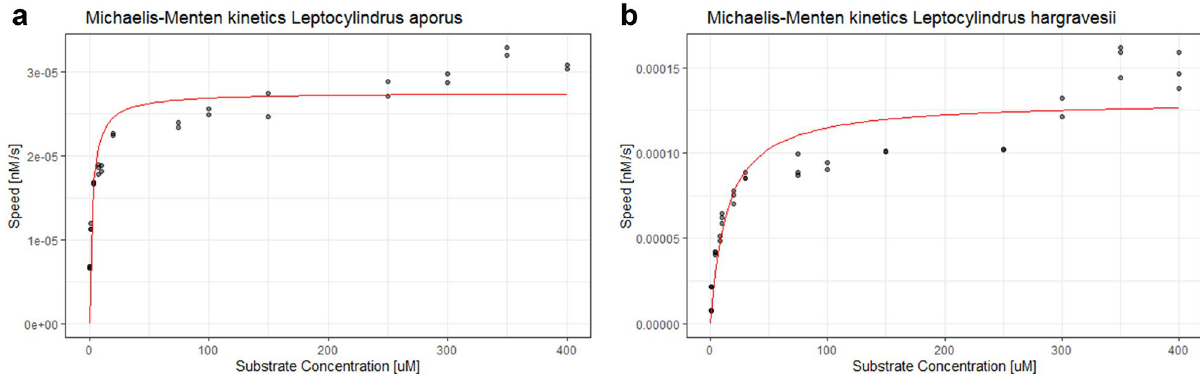
Figure 13. The AP enzyme kinetics of L. aporus ( a ) and L. hargravesii ( b ).